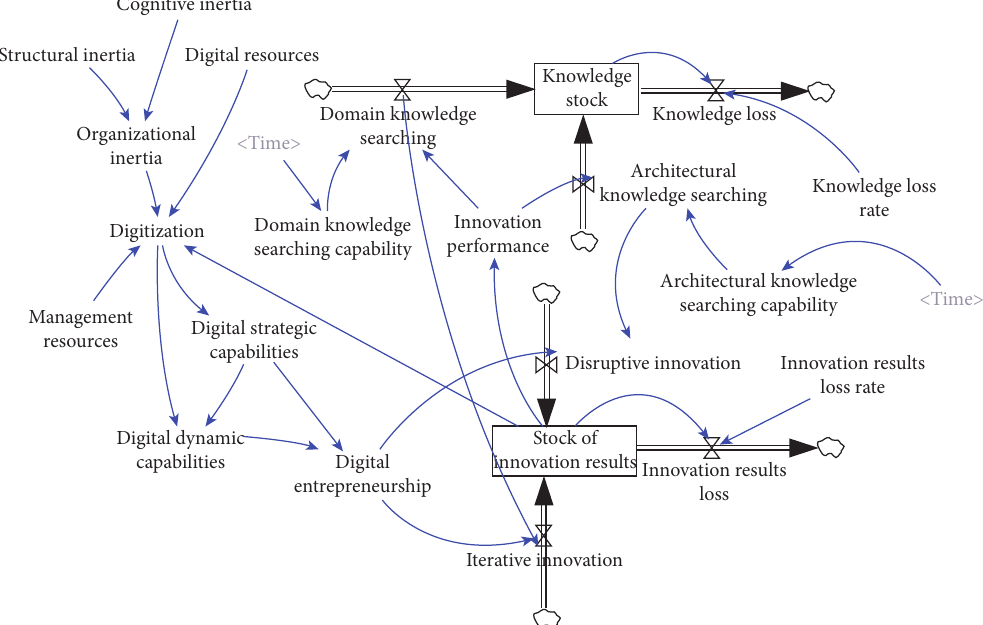
Figure 3: The system dynamics